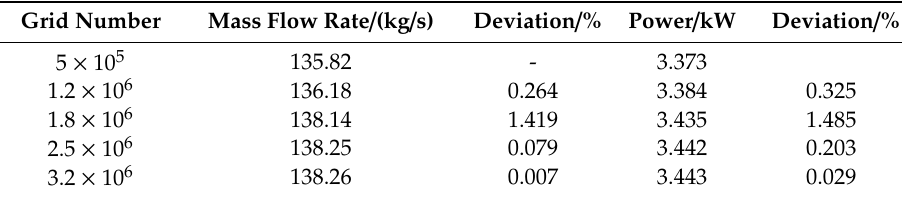
Table 4. Grid independence study.